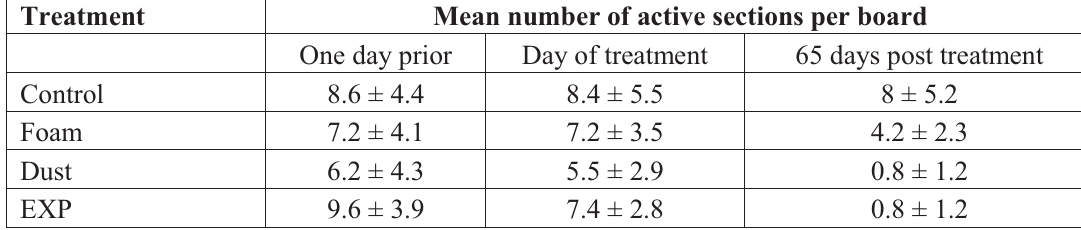
Table 3. Mean number ( (cid:3) SD) of active sections per board by treatment as determined by Termatrac (cid:2) motion detector.